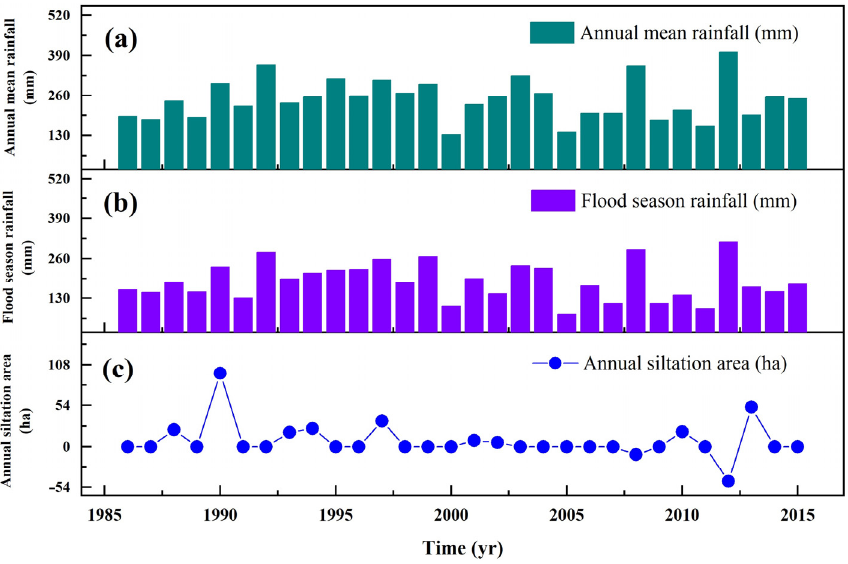
Figure 6. Annual trend of ( a ) annual mean rainfall, ( b ) flood season rainfall, and ( c ) annual siltation, respectively, from 1986 to 2015.